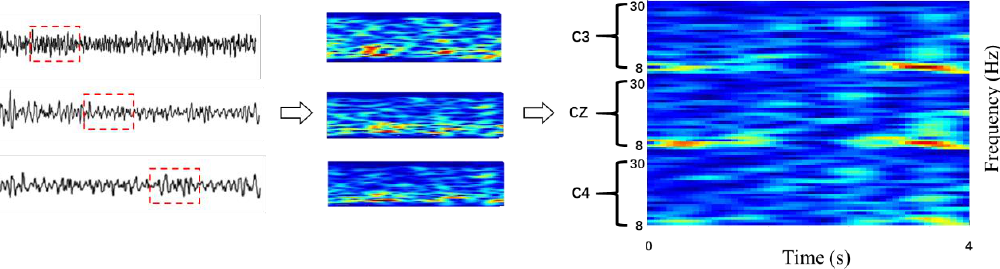
Figure 3. Input images with the electrodes after the short-time Fourier transform (STFT).